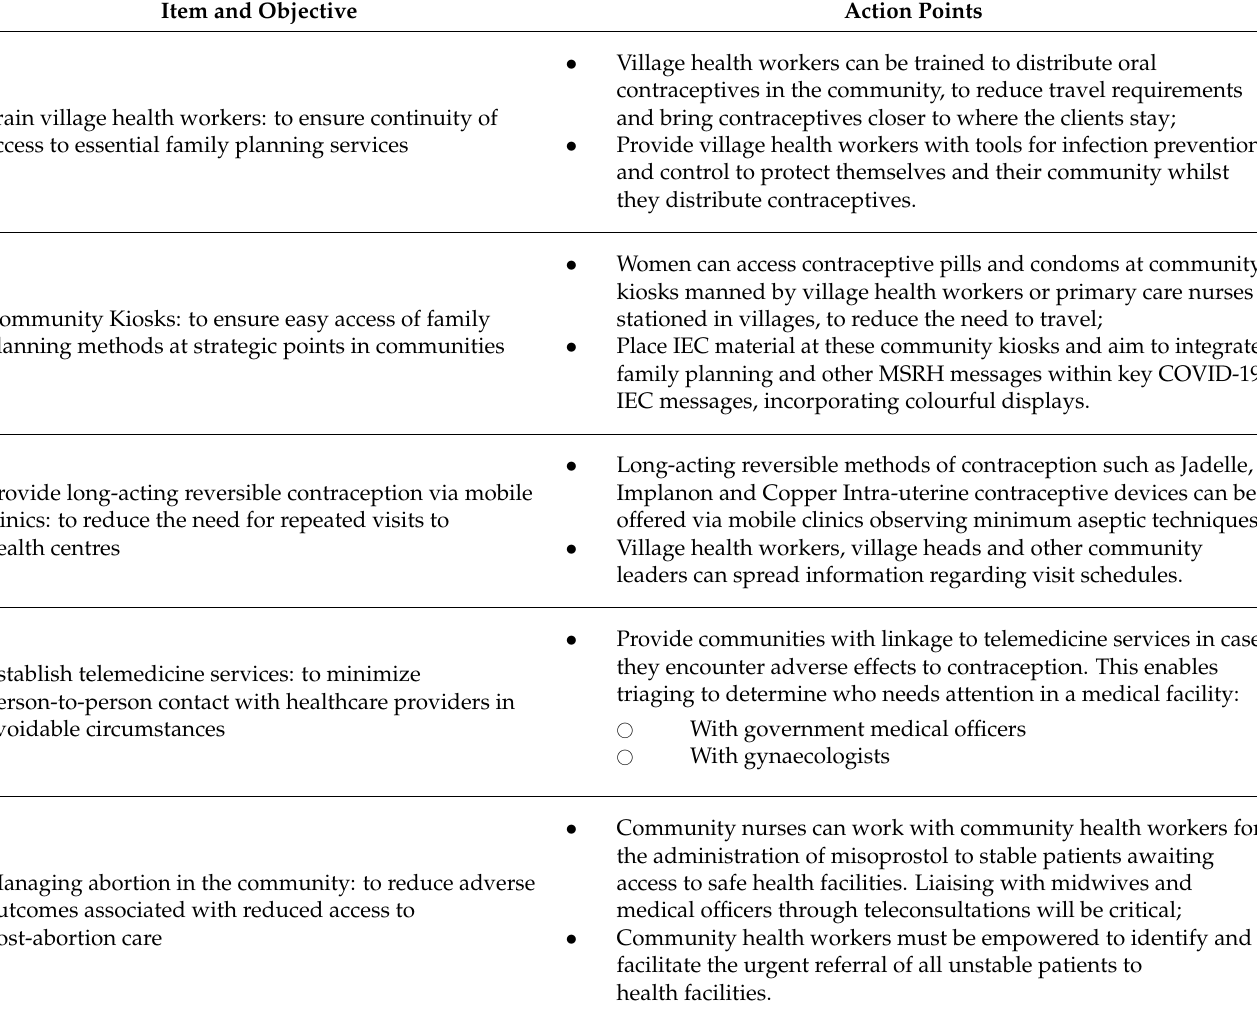
Table 1. Maintaining essential family planning activities and managing abortions at the community level during the COVID-19